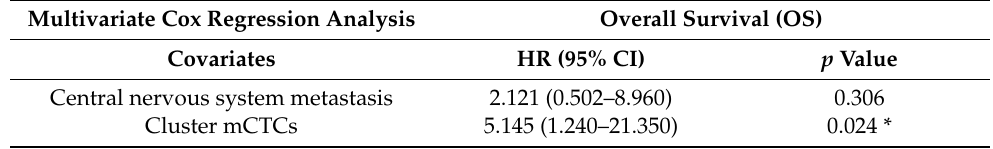
Table 3. Multivariate Cox regression analysis for OS (Patients: n =